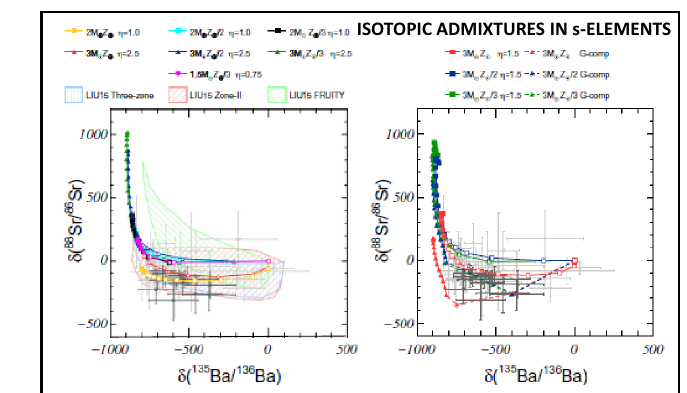
Figure 4. Examples of the agreement achieved between s -process models with MHD-induced 13 C reservoirs and the record of trace-element isotopic ratios in single SiC grains. The light dots with error bars represent the measurements; the heavy dots and the curves are from models of the indicated stellar masses, with mass loss estimated from the Reimers’ parameterization (its e ffi ciency is characterized by the η value shown). The term "G-component" refers to the material cumulatively mixed to the envelope from the He-intershell, without dilution with envelope material (see [28] for